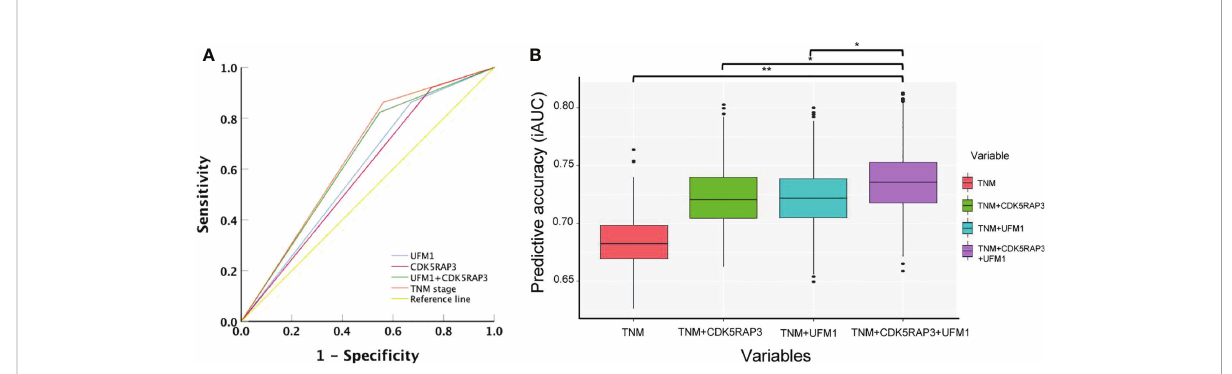
FIGURE 5 Combined CDK5RAP3 and UFM1 expression was used to evaluate the prognosis of patients with gastric cancer. (A) Receiver operating characteristic analysis of the predictive value. (B) Comparison of the prognostic prediction accuracy of patients among CDK5RAP3 or UFM1 combined with TNM staging, coexpression of CDK5RAP3 and UFM1 combined with TNM staging and separate TNM staging (A box plot depicts the forecast accuracy of the 5-year overall survival based on the iAUC with 1000× bootstrap resampling). *p < 0.05; **p <